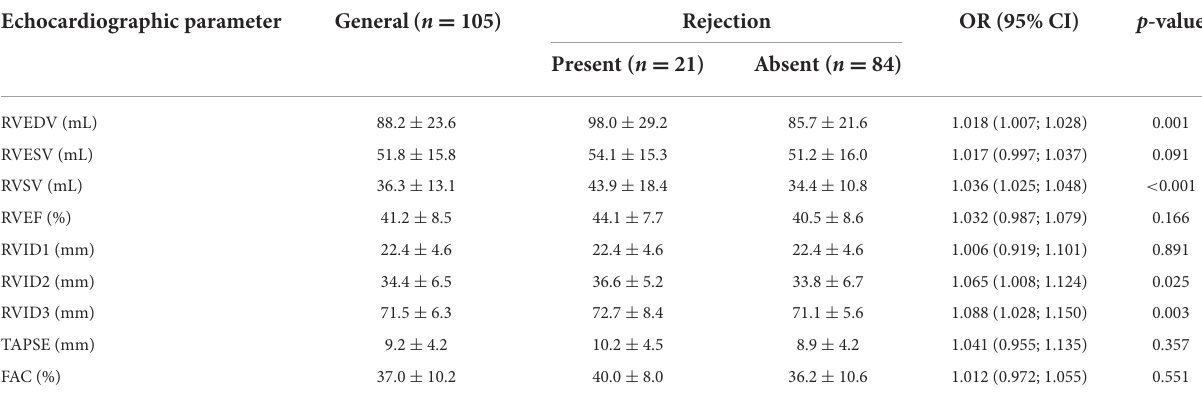
TABLE 4 Morphological and functional echocardiographic parameters of the right ventricle according to rejection. Echocardiographic